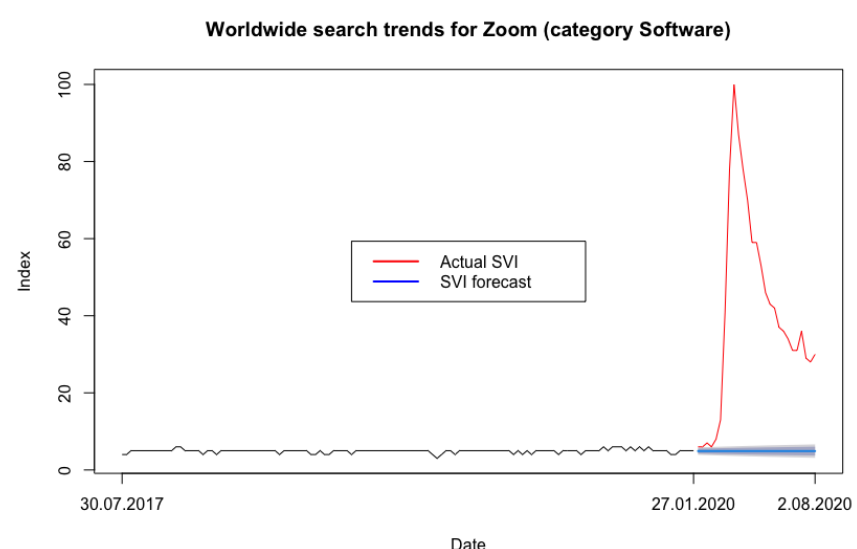
Figure A1. Forecasted trend for GT web queries (SVI) for the keyword “Zoom” (category “Software”) at world level over 27 January 2020–2 August 2020 issued with ETS (A,N,N). Source: estimation results. Model Information: Smoothing parameters: alpha = 0.4283, Initial states: l = 4.7561, sigma: 0.444.